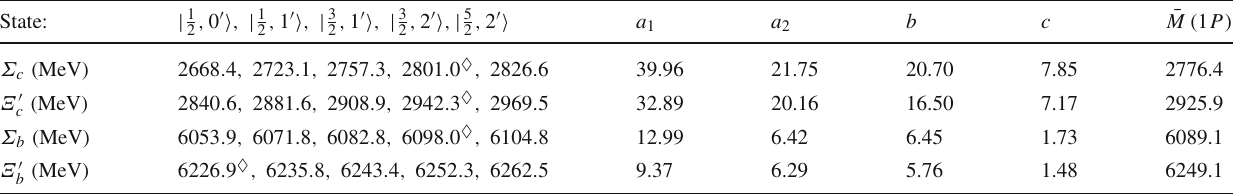
Table 8 Masses and parameters (all in MeV) refined from the initial inputs in Table 7 via iteration of the nonlinear relation (7) for the less strange heavy baryons Σ c /Ξ (cid:2) c and Σ b /Ξ (cid:2) in b